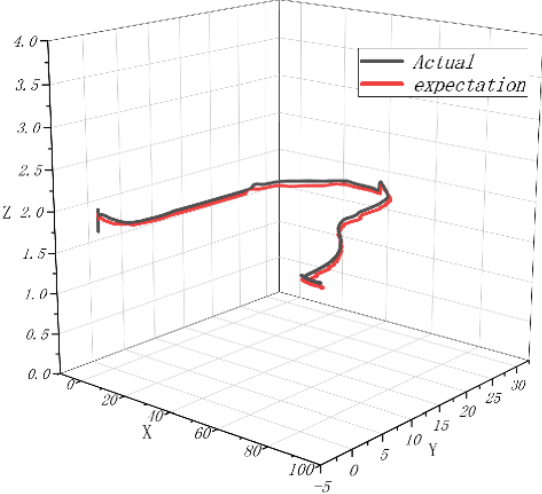
Figure 14. Expected value and actual value of dynamic flight path.